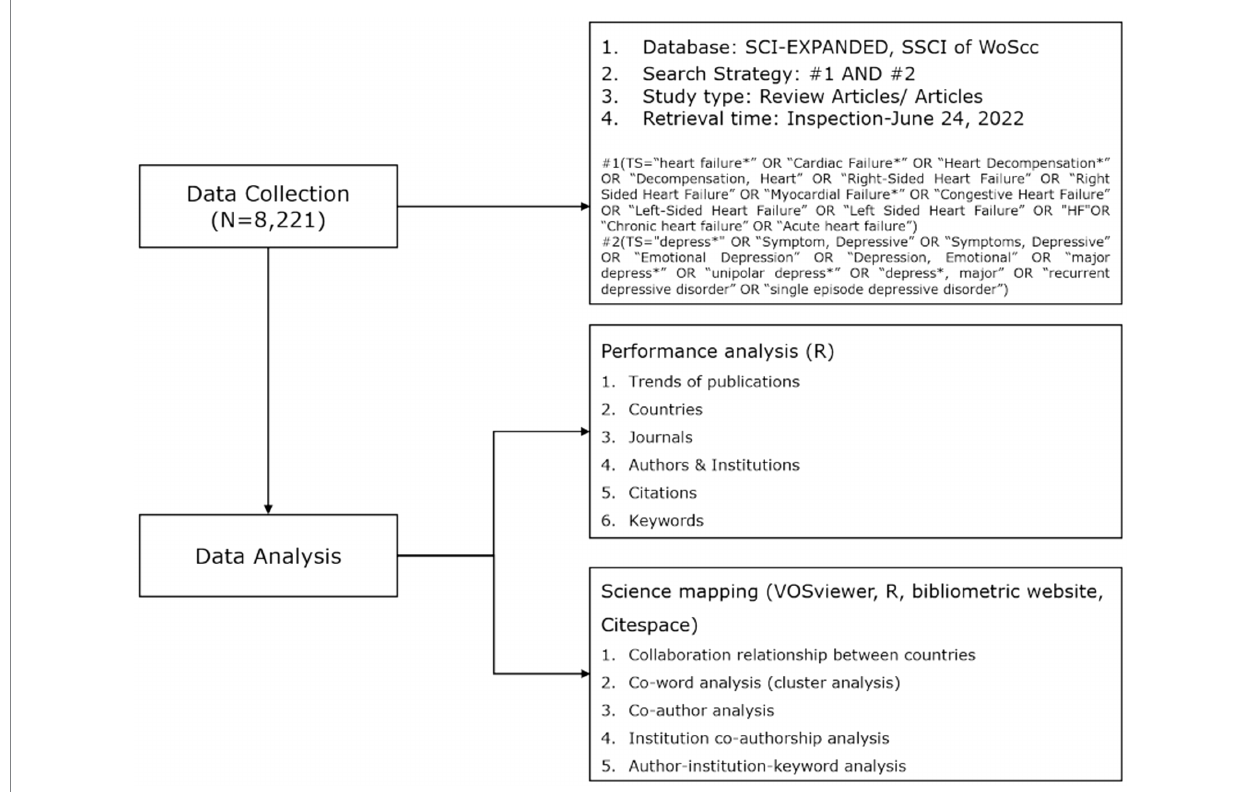
FIGURE 1 Flowchart of data collection and study